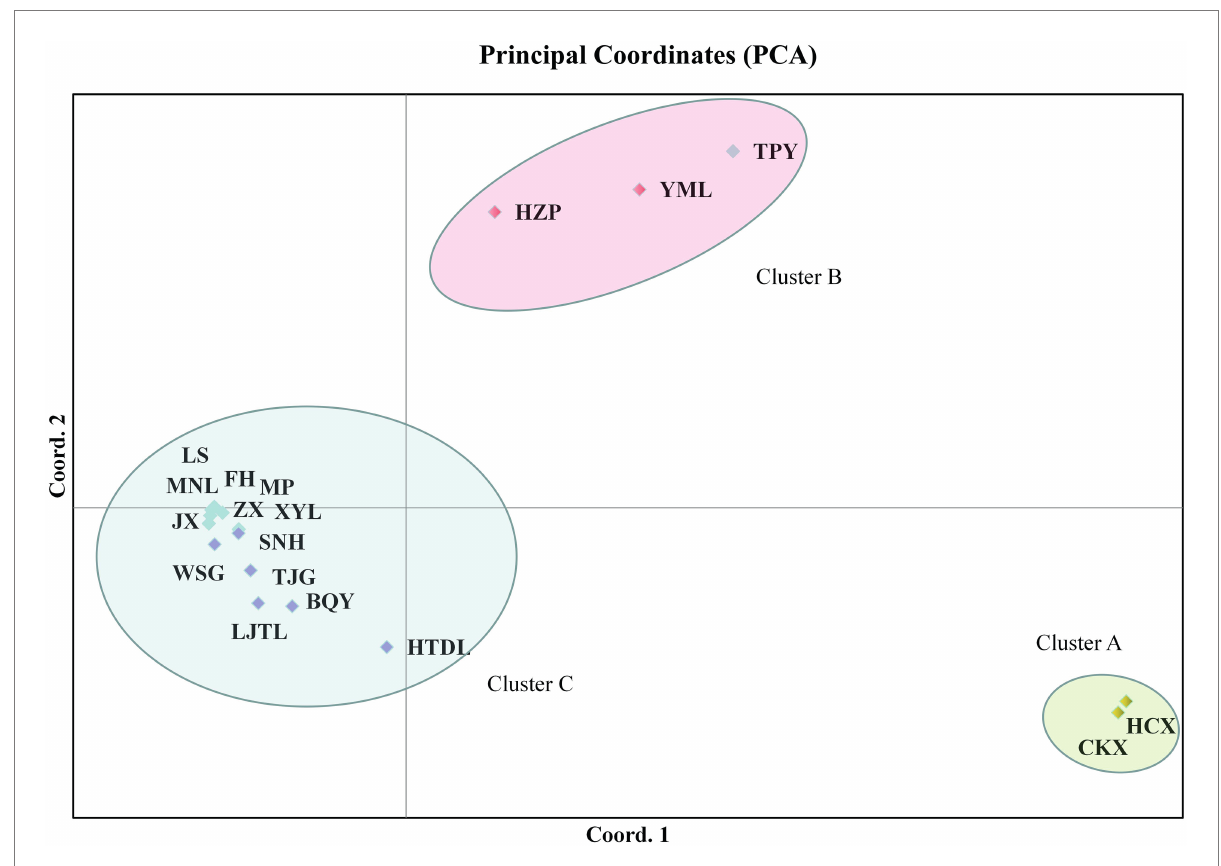
FIGURE 5 Principal component analysis (PCA) of the 18 tested populations based on